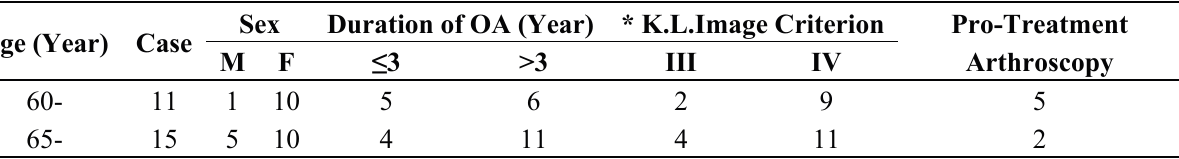
Table 1. Information of osteoarthritis (OA) patients with total knee replacement surgery. Age (Year)